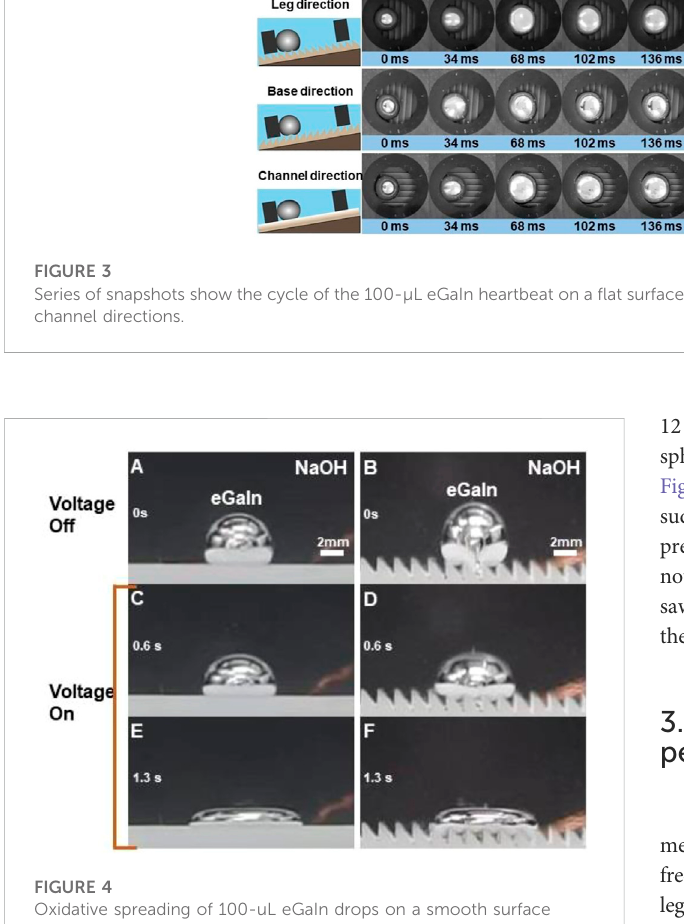
FIGURE 4 Oxidative spreading of 100-uL eGaIn drops on a smooth surface and a 1.5-mm ratchet substrate in a 1.5 mol/L NaOH solution of 12 V voltage. (A-B) States before power is turned on. (C-D) States after power is turned on for 0.6 s. (E-F) States after power is turned on for 1.3